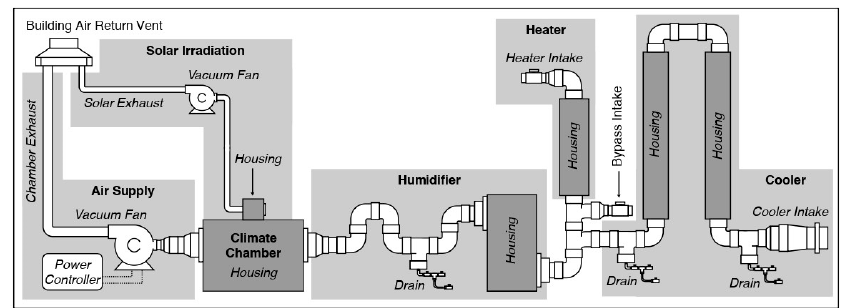
Figure 1. System layout of bench-scale atmosphere